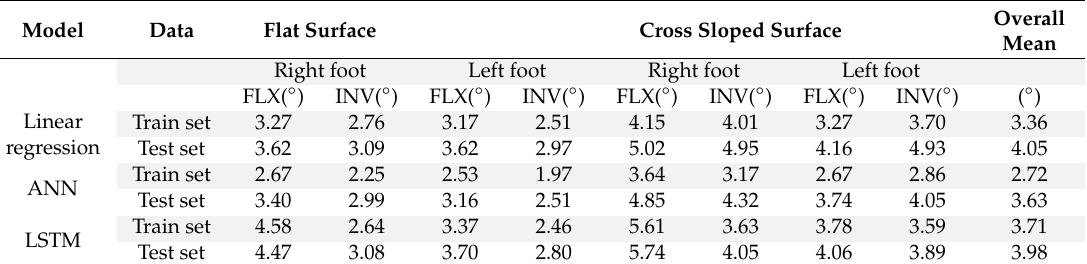
Table 1. Mean of root mean squared error (RMSE) values in degrees ( ◦ ) for linear regression, ANN, and LSTM. The lower values indicate better performance (FLX = flexion; INV = inversion).